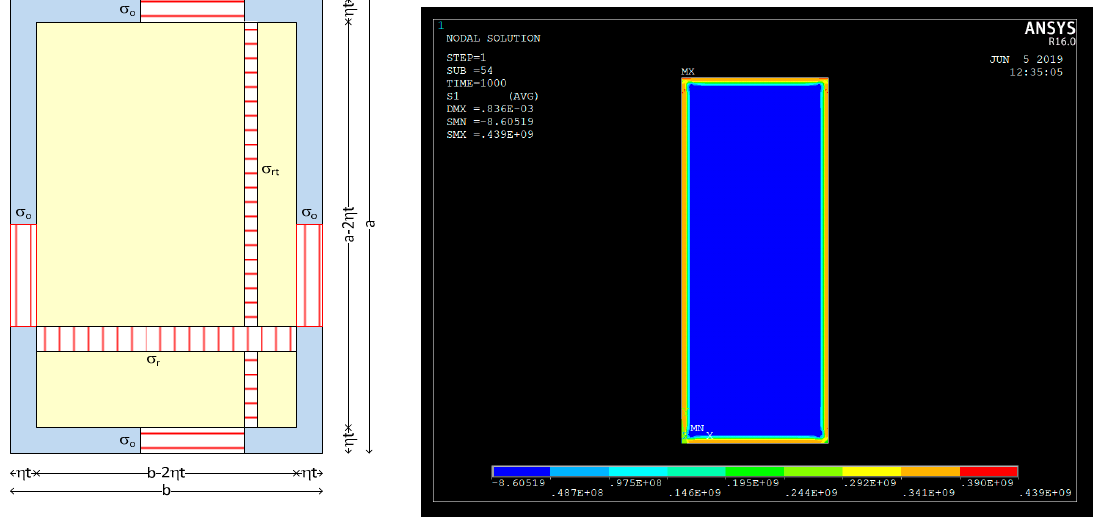
Figure 1. Idealized residual stress model for an unstiffened perfect plate welded in the edges ( left ) and results by FE thermal analysis ( right ).